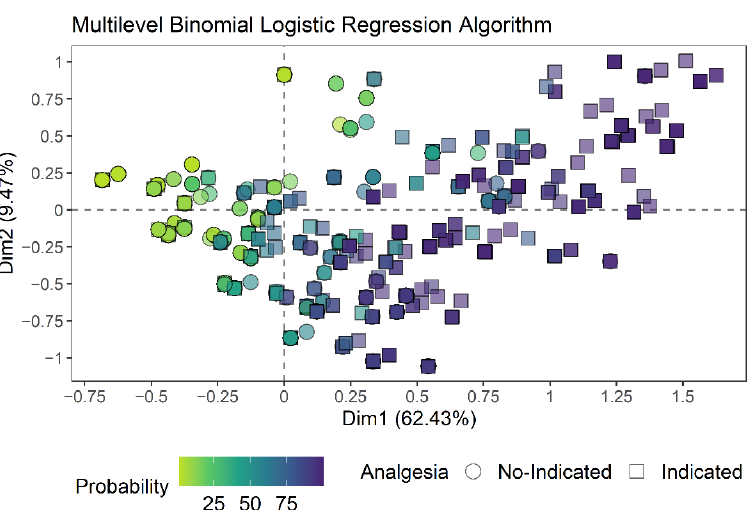
Figure 3. Two-dimensional perceptual map of the multiple correspondence analysis showing the dispersion of expert opinion of no-indication or indication to apply analgesia and probability of sheep needing analgesia according to the multilevel binomial logistic regression model (Circles and squares indicate each evaluation; the greater the number of dark squares and the greater the number of light circles, the greater the accuracy of the algorithm).